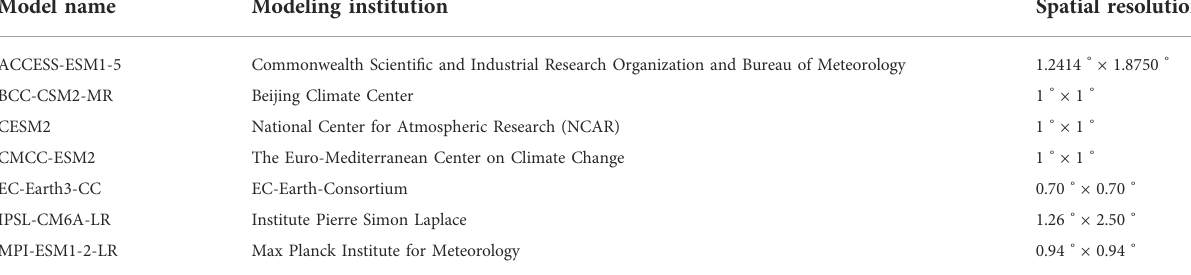
TABLE 2 The detailed information of 7 CMIP6 ESMs that are used for the factorial